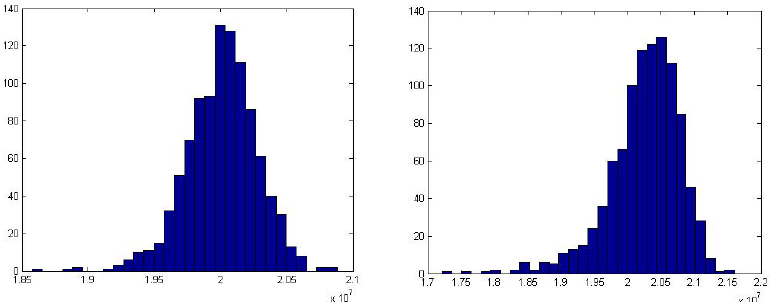
emisssions over twenty years. Yearly average ( L 1 ): 2